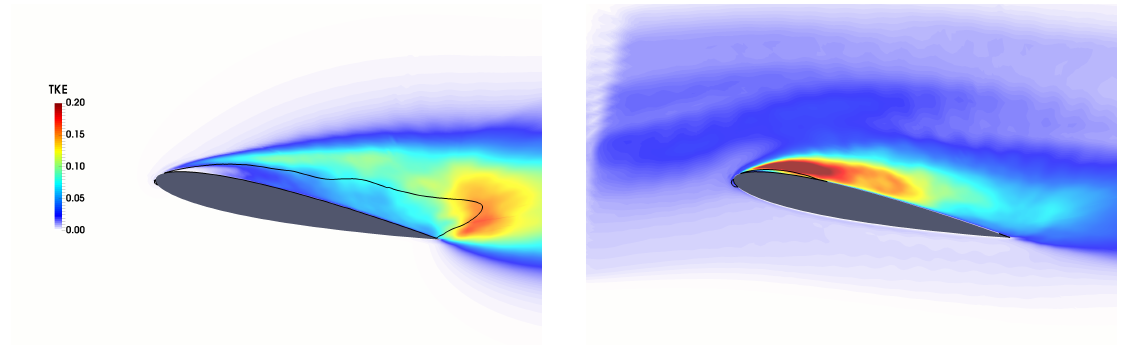
Figure 11. Contours of mean turbulent kinetic energy (TKE) in laminar ( left ) and turbulent ( right ) freestream conditions. The reverse flow zone is indicated by a black